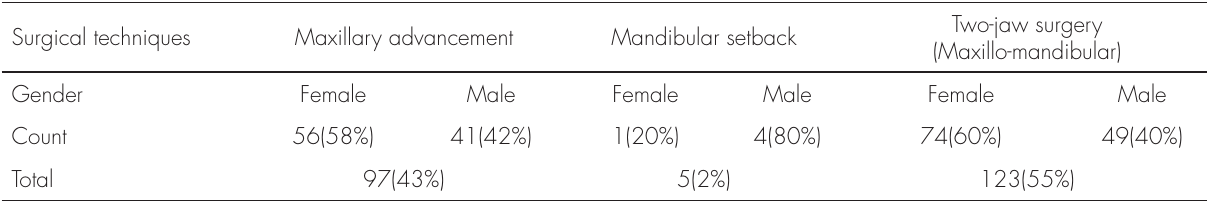
Table I. Distribution of study sample showing counts and percentages of skeletal Class III orthognathic procedures by